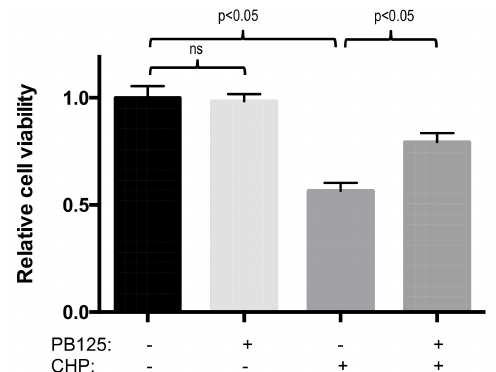
Figure 4. PB125 prevented oxidative stress-induced loss of cell viability. Cytotoxicity was not observed (cell proliferation measured by CCK8 assay) in HepG2 cells treated overnight with 5 µ g / mL PB125 compared to vehicle control blank. In HepG2 cells cultured for 18h with 5 µ g / mL PB125 or vehicle control, from which the culture media was removed and replaced and the cells were challenged with an oxidative stress by treatment with 25 µ M cumene hydroperoxide (CHP) or untreated control for 6 h, cell toxicity (loss of viability) was caused by cumene hydroperoxide treatment but this toxicity was partially attenuated ( p < 0.05) by PB125 pretreatment. ns: not